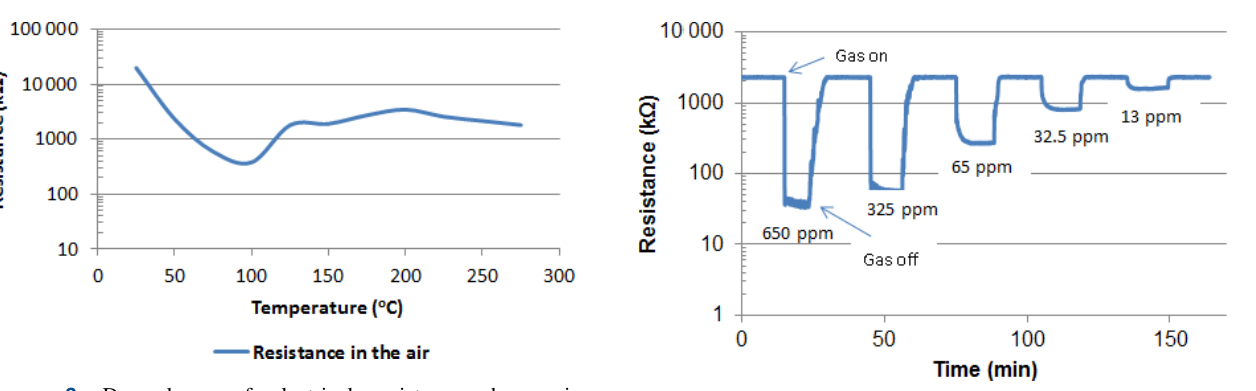
Figure 5. The response–recovery curves observed at different PG concentrations measured at 200 ◦ C operating temperature.